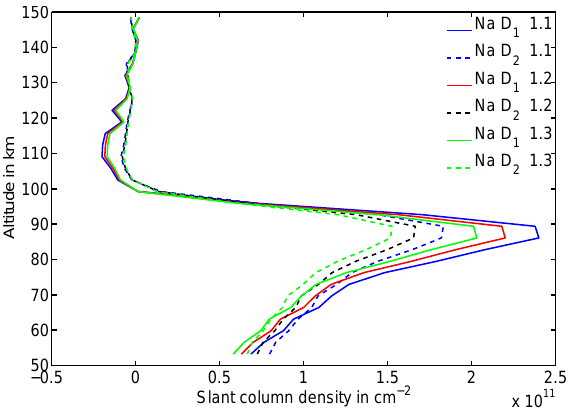
Figure 7. Vertical Na number density profile retrieved from the SCD profiles shown in Fig. 6. For albedo factors that are too large, the densities are smaller and the D 1 line shows higher densities. For a albedo factor that is too small, the D 2 line shows higher densities. For the optimum albedo factor (here 1.2), both Na lines yield the same